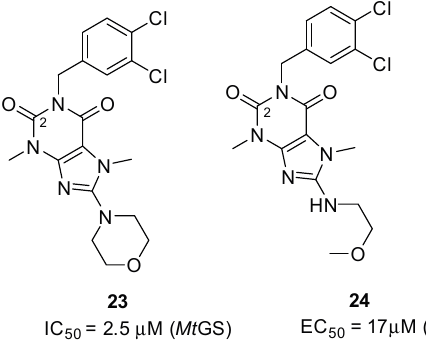
Figure 8. Structure and Mt GS inhibitory activity of the diketopurine compounds 23 and 24 .